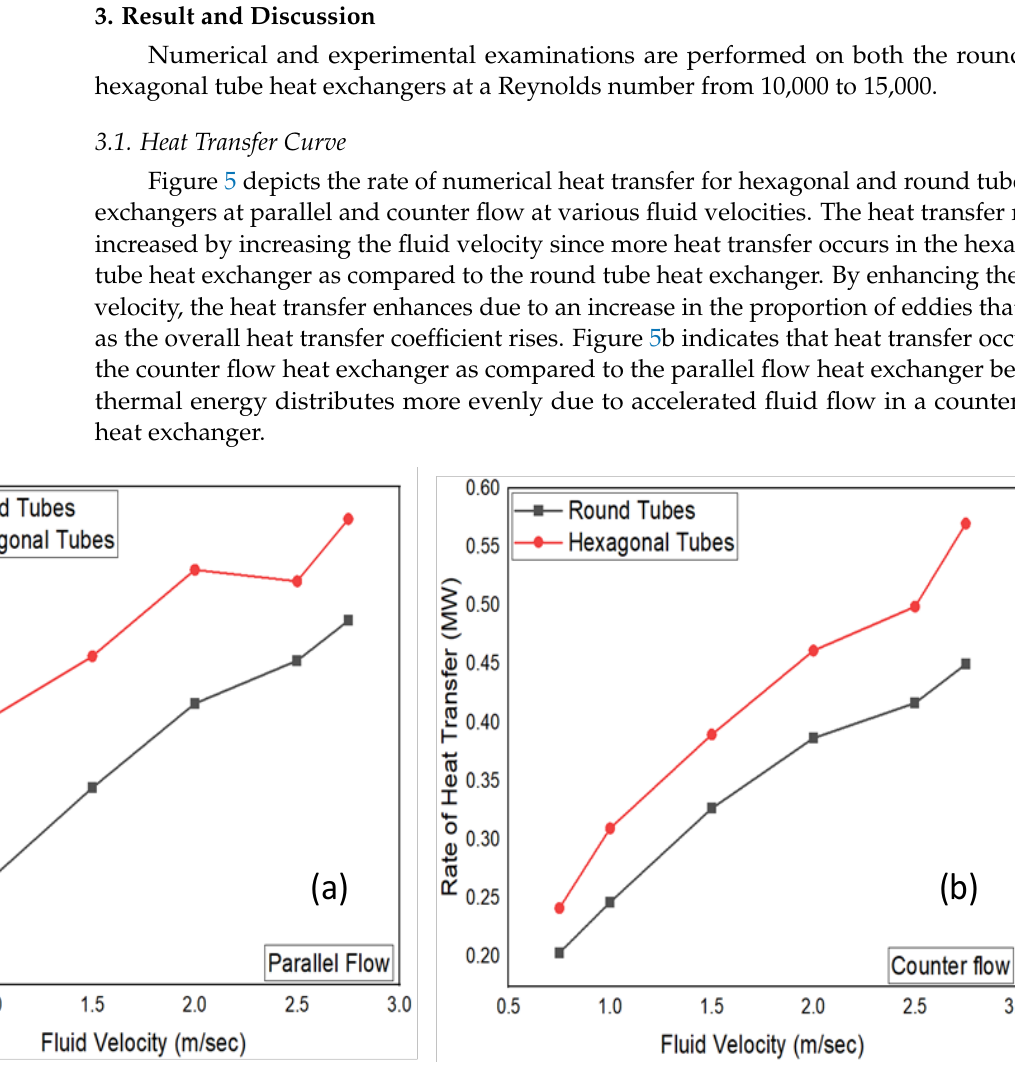
Figure 5. ( a ) Variation of the heat transfer rate due to fluid velocity in parallel flow; ( b ) variation of the heat transfer rate due to fluid velocity in counter flow.